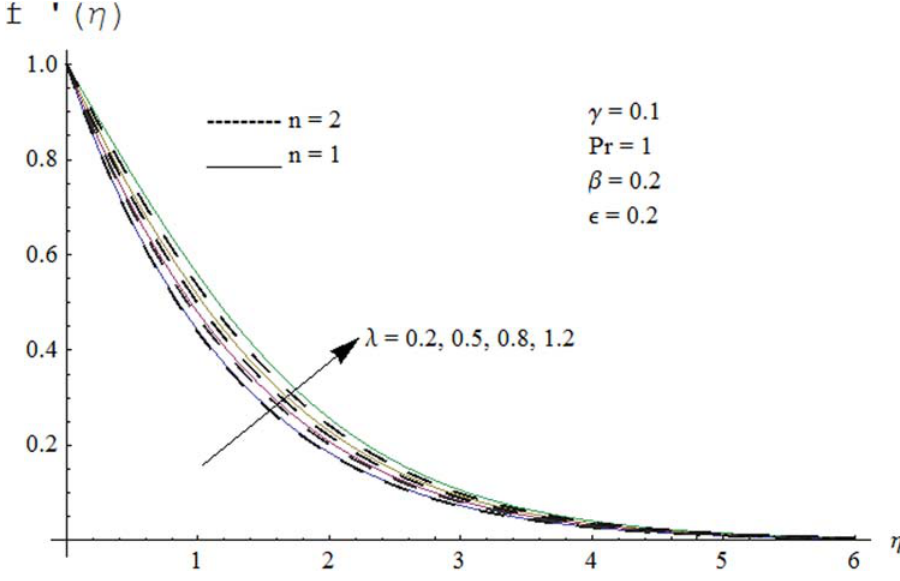
Fig 7. Effect of λ on velocity